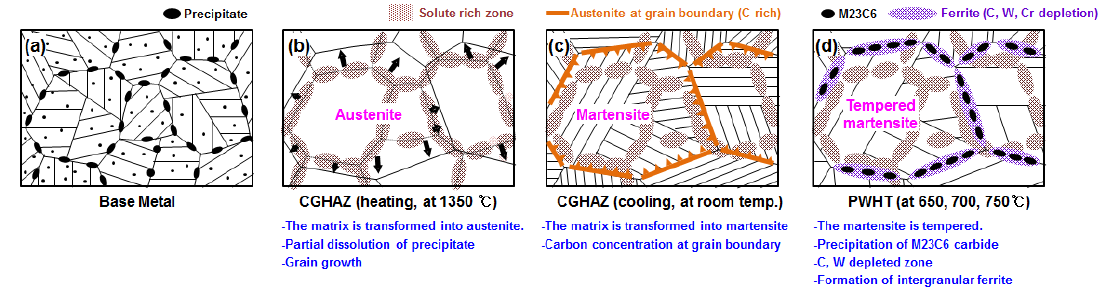
Figure 15. Schematic illustration of microstructural evolution. ( a ) Base metal; ( b ) CGHAZ (heating, at 1350 °C); ( c ) CGHAZ (cooling, at room temp.); ( d ) PWHT (at 650, 700 750 °C).